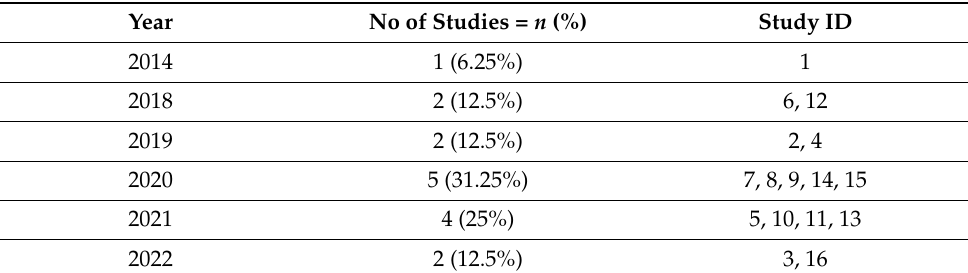
Table 4. Timeline of studies included in this review.